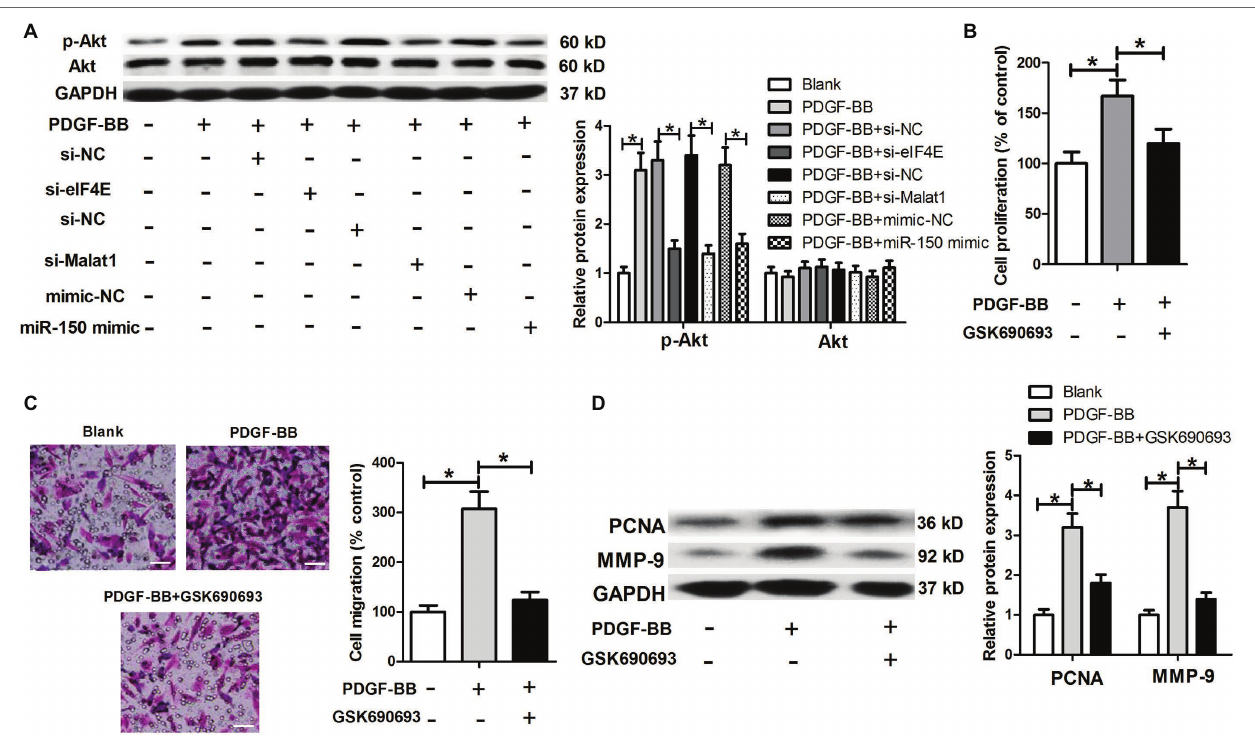
FIGURE 6 | Malat1/miR-150/eIF4E signal axis regulates the Akt signaling in PDGF-BB-treated ASMCs. (A) Akt and p-Akt expression in PDGF-BB-treated ASMCs transfected with si-eIF4E, si-Malat1, miR-150 mimic, or their respective control. (B–D) The effects of GSK690693 on PDGF-BB-induced ASMC proliferation and migration determined by MTT, Transwell (scale bar: 100 μ m), and western blot assays. * p <